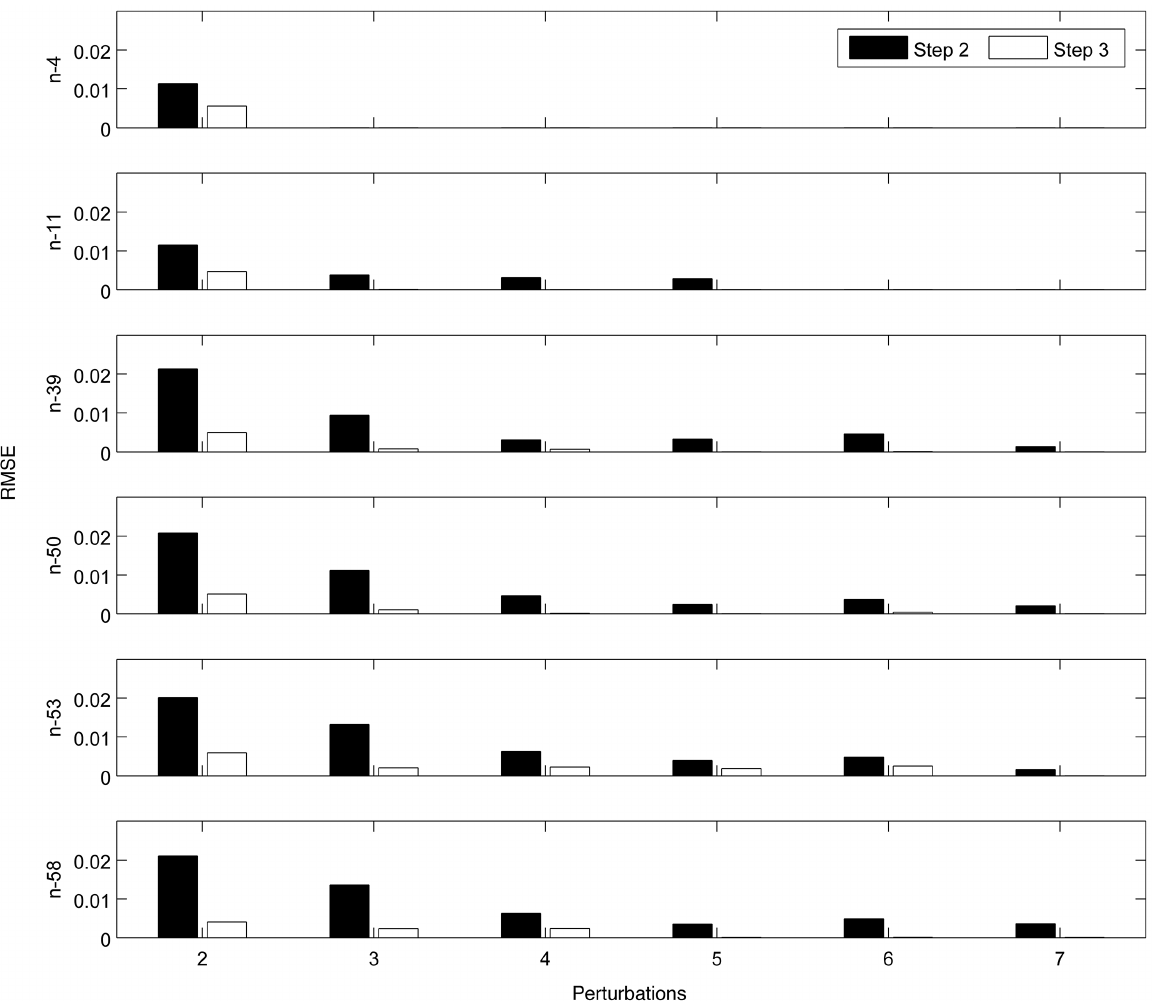
Figure 7. Bar charts of RMSE for inferred transition matrices. These charts show the results of both Step 2 and Step 3 for 6 different benchmark networks with different numbers of perturbations varying from 2 to 7. In Step 2, the RMSE values range from 1 : 9 | 10 { 6 to 2 : 1 | 10 { 2 with the mean value of 6 : 2 | 10 { ; in Step 3, the RMSE values range from 1 : 6 | 10 { to 5 : 9 | 10 { with the mean value of 1 : 3 | 10 { 3 . The RMSE ratios (Step 3/Step 2) vary from 0.14% to 51% with the mean value of 17%.